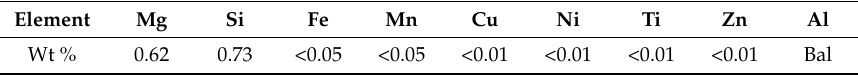
Table 1. The chemical composition of 6A02 aluminum alloy.